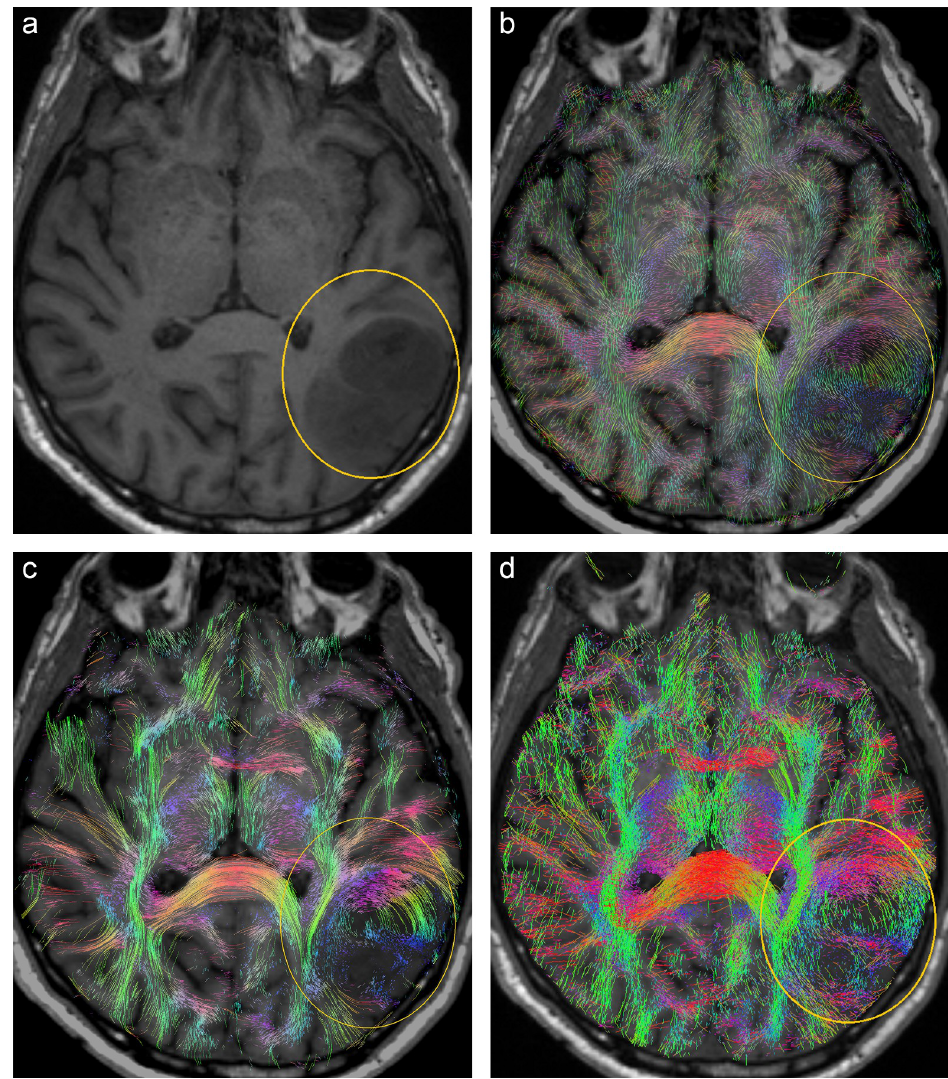
Fig 6. Visualization results from patient D (transaxial slices): (a) T1 image with ROI (yellow), corresponding slices from A-Glyph LIC (b), deterministic (c) and probabilistic (d)